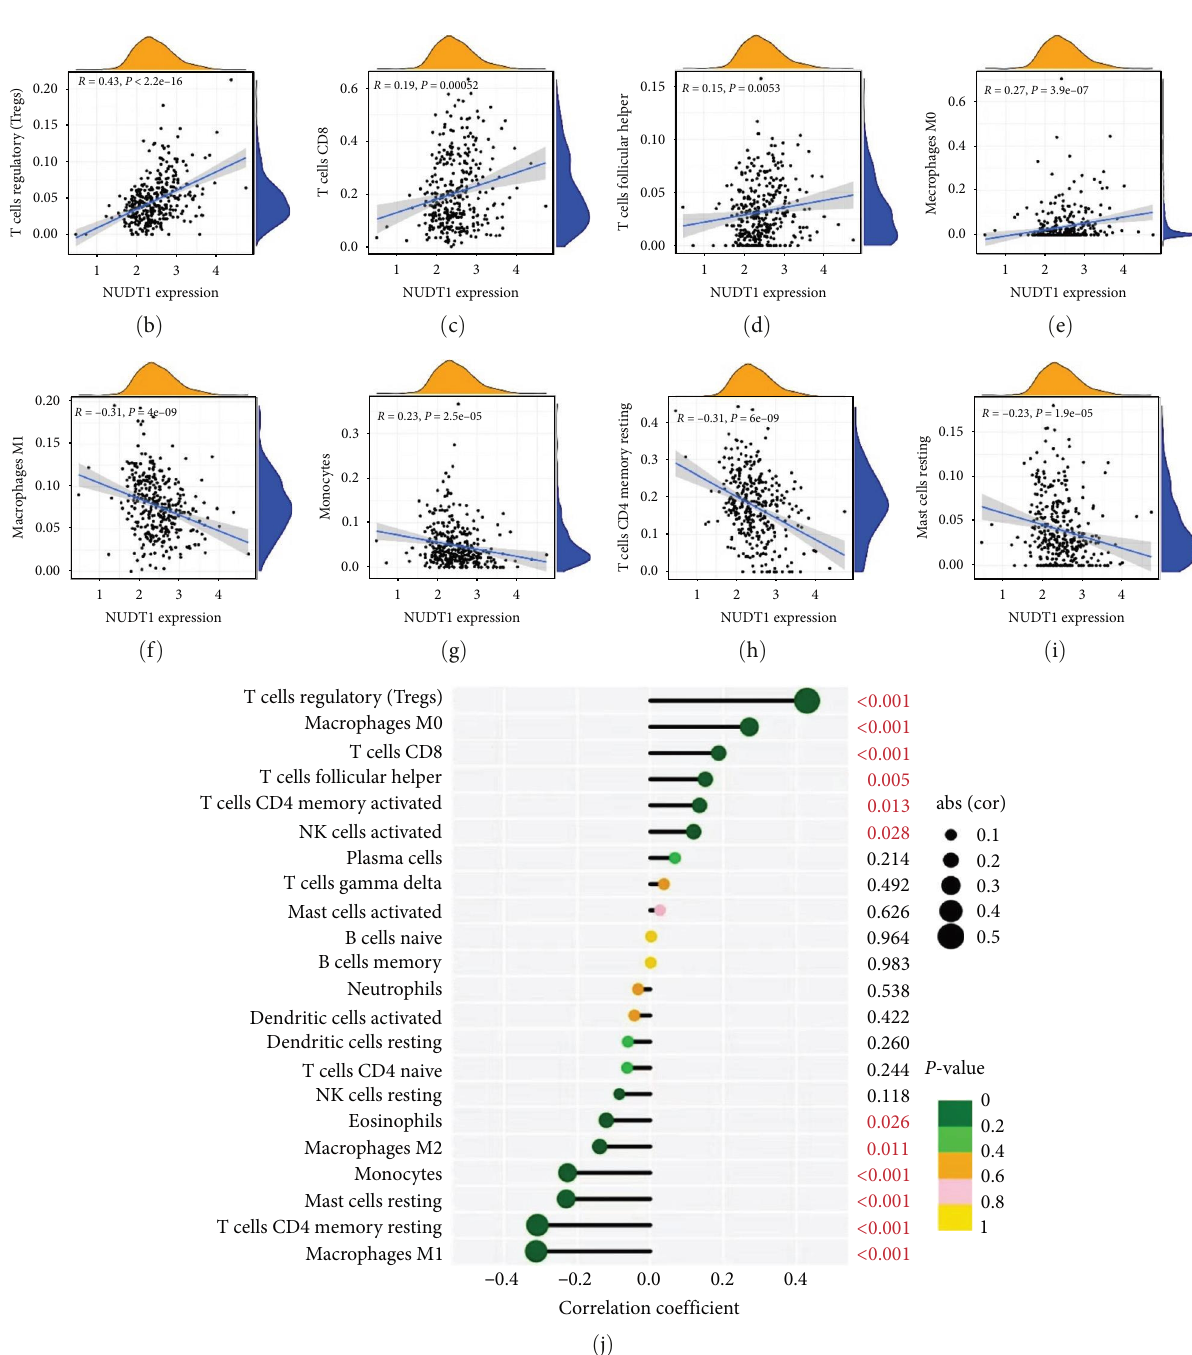
F IGURE 7: Correlation analysis between NUDT1 and immune in fi ltration: (a) the in fi ltration levels of 22 immune cell subtypes in the high- and low-NUDT1 expression group; (b – j) the correlation between tumor immune in fi ltrated cell levels and NUDT1 expression in ccRCC. ∗ P < 0 : 05, ∗∗ P < 0 : 01, ∗∗∗ P < 0 :